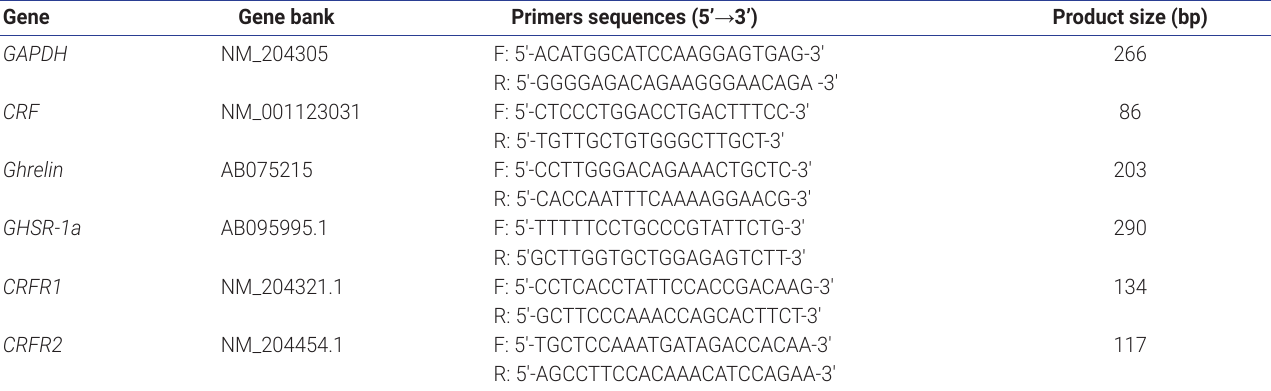
Table 2. Gene-specific primers of related genes Gene Gene bank Primers sequences (5’ → 3’)